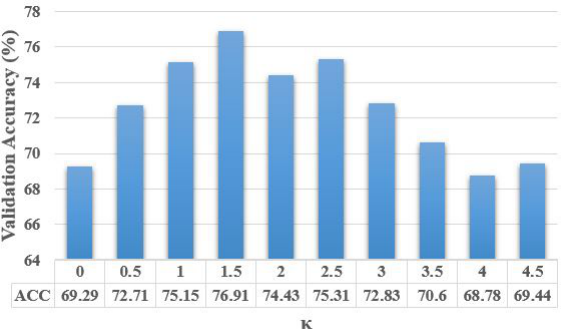
Figure 4. Validation accuracy of MI dropout model with different configurations of defined hyper- parameter κ in (10) on the CIFAR10 dataset.